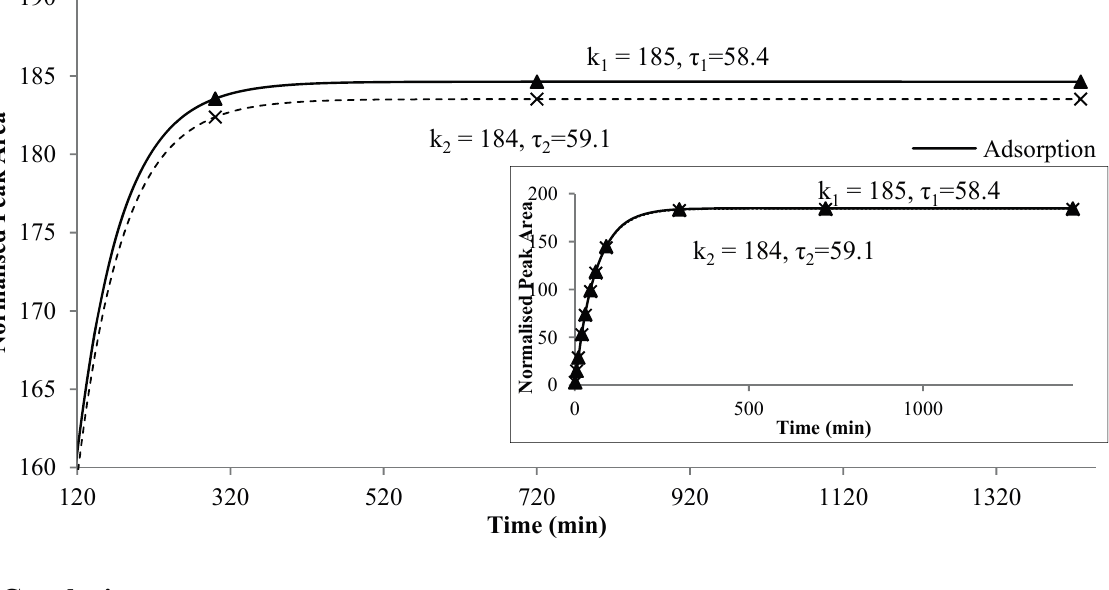
Figure 4. Two first-order reactions, i.e. , adsorption onto and release from the fiber of ethyl octanoate in alcohol beverage model system at 40